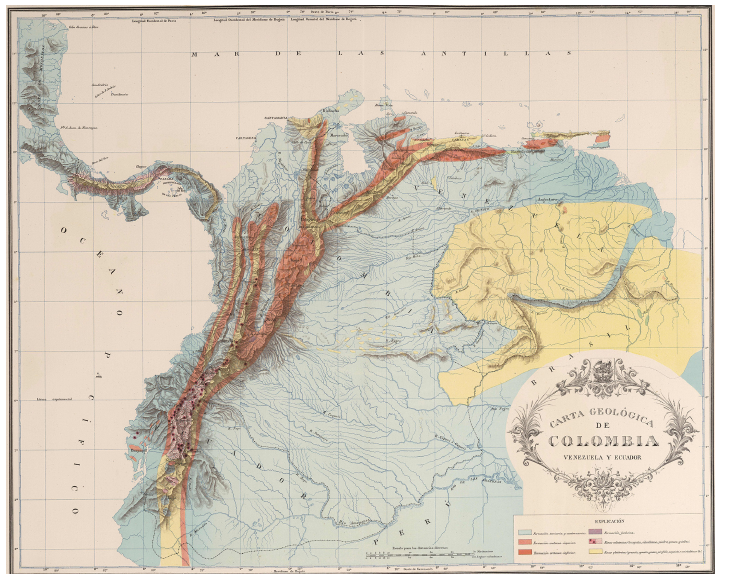
Figure 3. Geologic map of Colombia (Codazzi et al., 1889, plate XVII). Key: light blue – Tertiary and Quaternary, lighter orange – Upper Cretaceous, darker orange – Lower Cretaceous, purple – Jurassic, pink with asterisks – volcanoes, dotted pink – miscellaneous volcanic rocks, yellow – plutonic